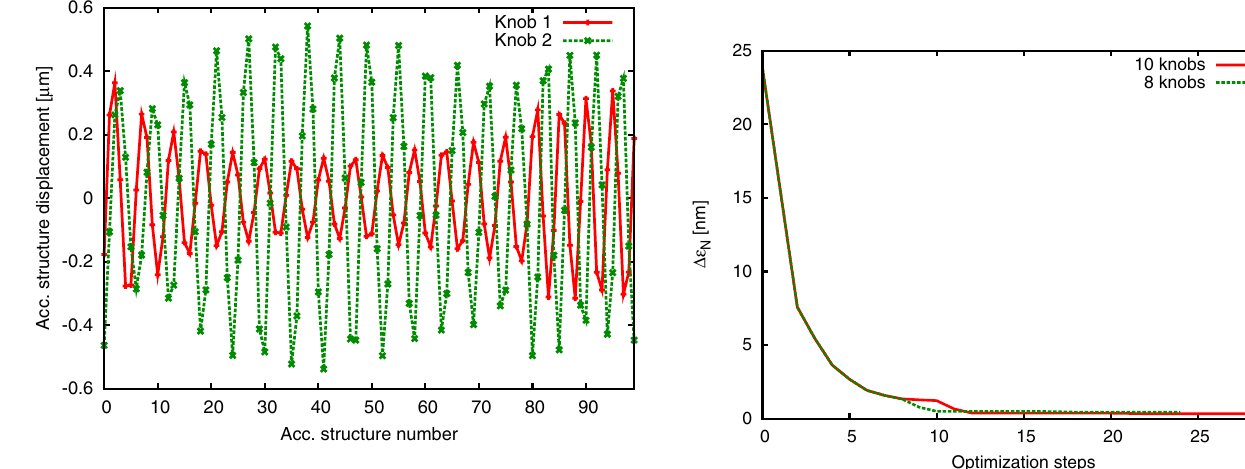
FIG. 17. Emittance growth reduction obtained using eight or ten knobs based on the ten strongest principal knob directions of a set of 662 knob vectors. For ten knobs the final emittance is lower, but convergence is slightly